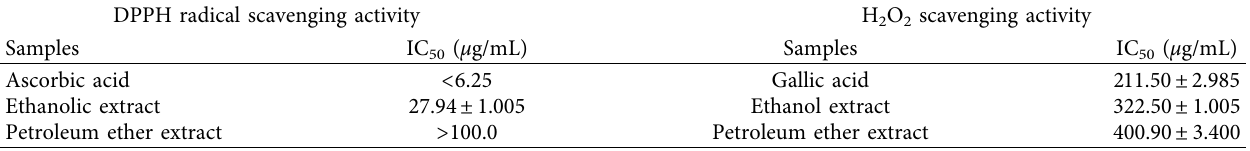
Table 6: IC 50 of DPPH/H 2 O 2 scavenging activity for the ethanol and petroleum ether extracts of C. nioroense and ascorbic acid/gallic acid.